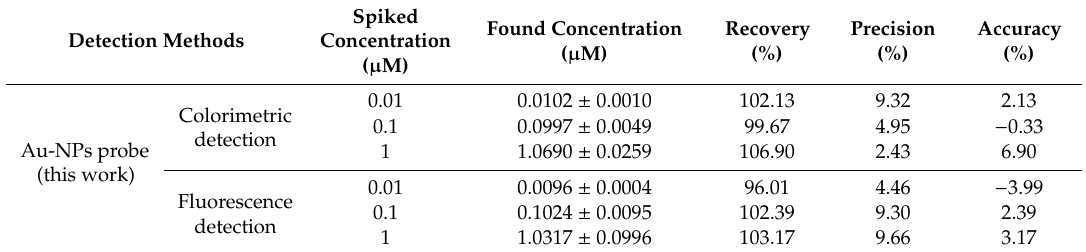
Table 1. Analytical data for the colorimetric and fluorescence detection of histamine in real samples by Au-NPs probe,